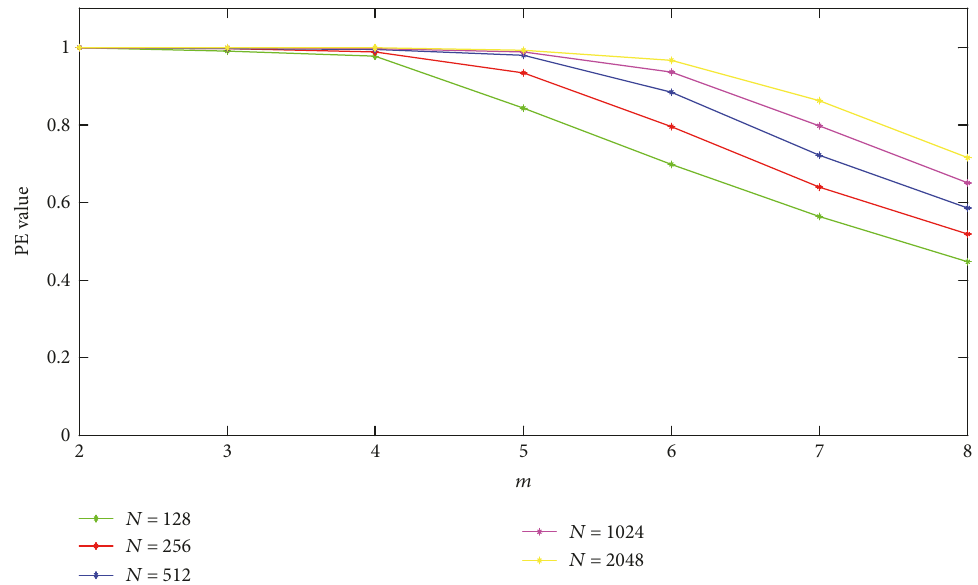
Figure 5: The PE value of di ff erent lengths N and embedded dimensions m of